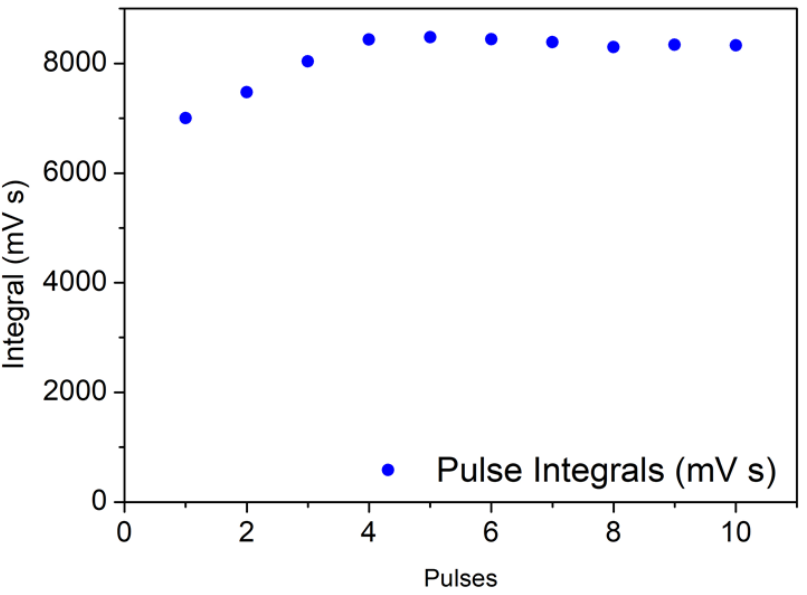
Figure 5. 25,000 km sample: integrals of TCD signal peaks registered during successive manual dosage of pulses of 800 µL of 10% CO in He carrier, until saturation.